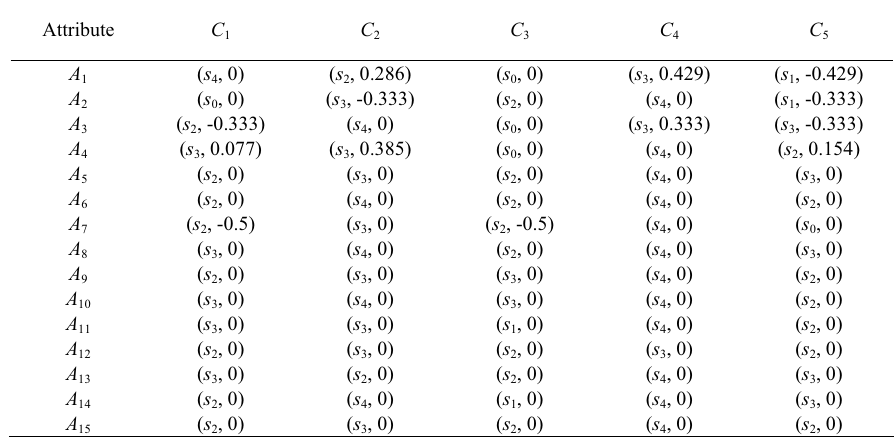
Table 11. Linguistic 2-tuple decision